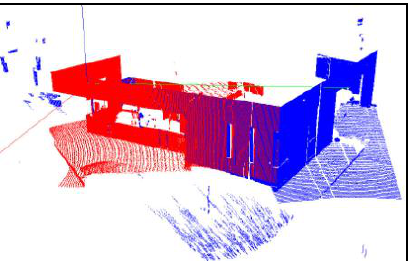
Figure 10. Registration result for Building A .